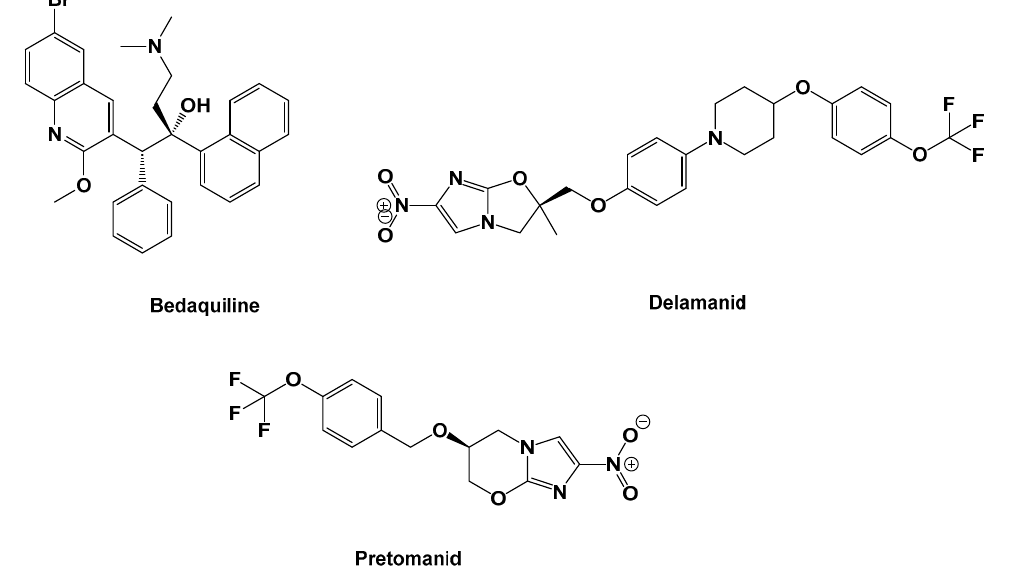
Figure 1. Chemical structure of recently clinically approved anti-tuberculosis (TB) drugs.